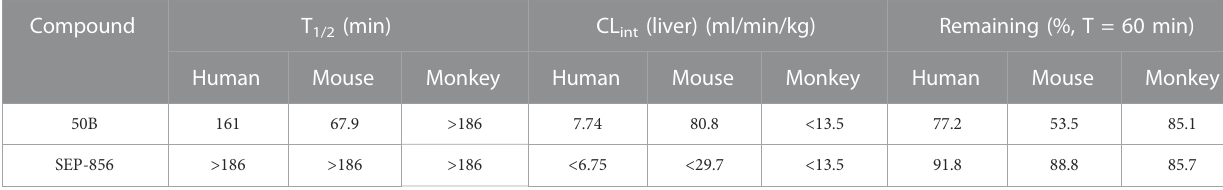
TABLE 3 Microsomal metabolic stability in liver microsomes from different species. Compound T 1/2